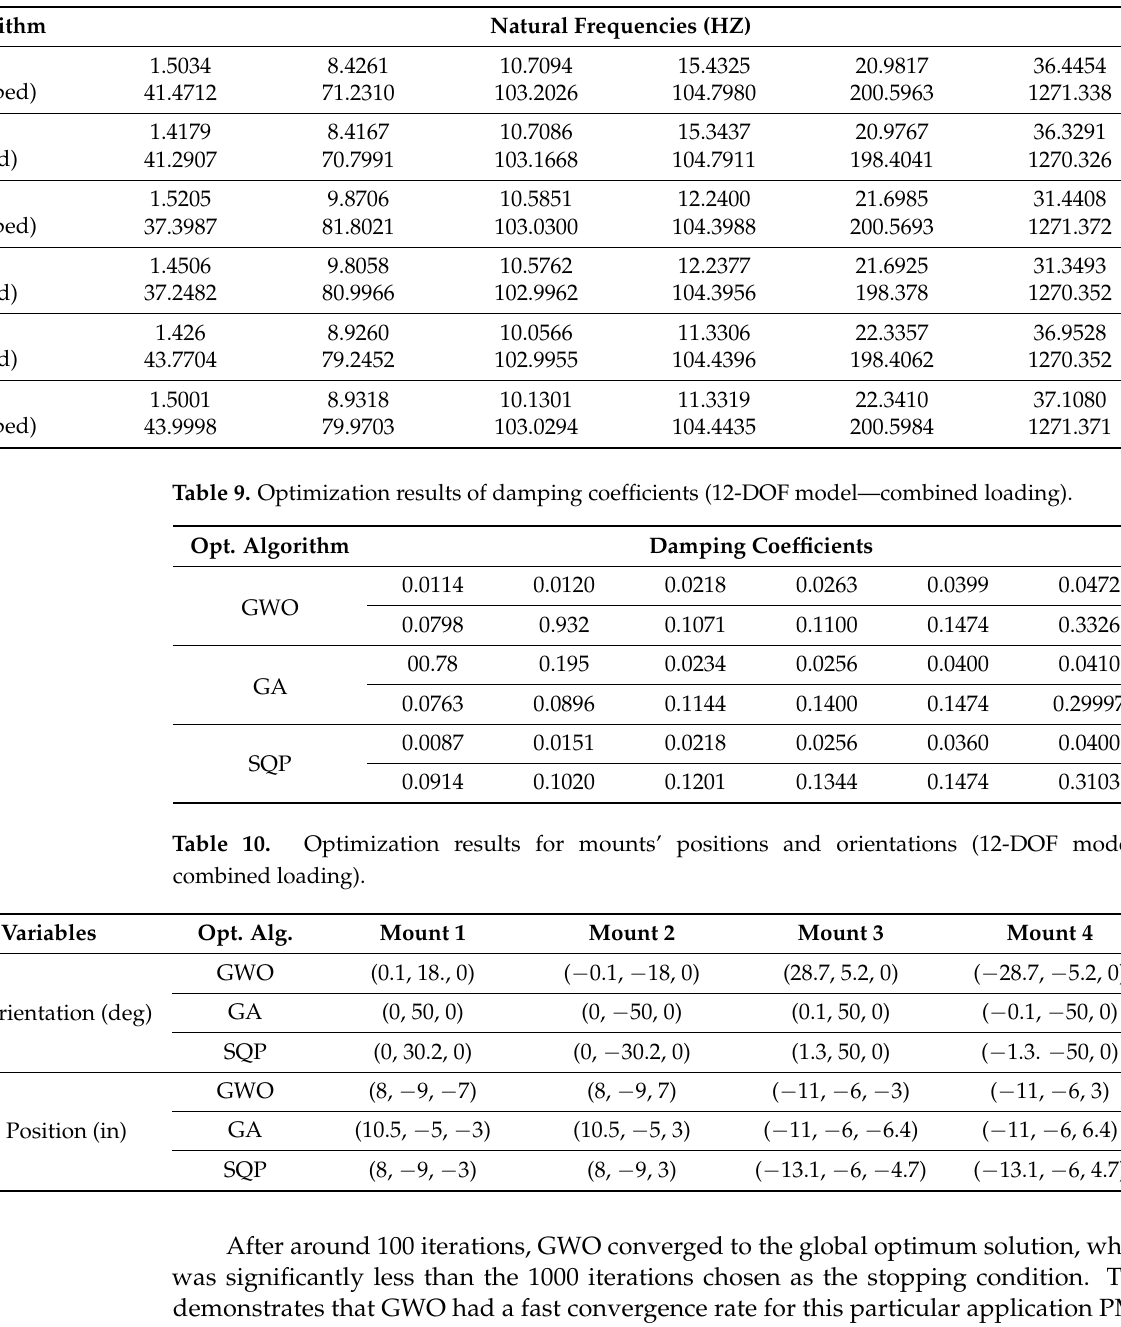
Table 8. Optimization results of natural frequencies (12-DOF model—combined loading).